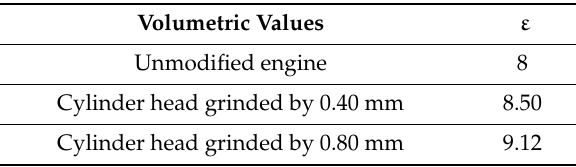
Table 3. Altered compression rates.